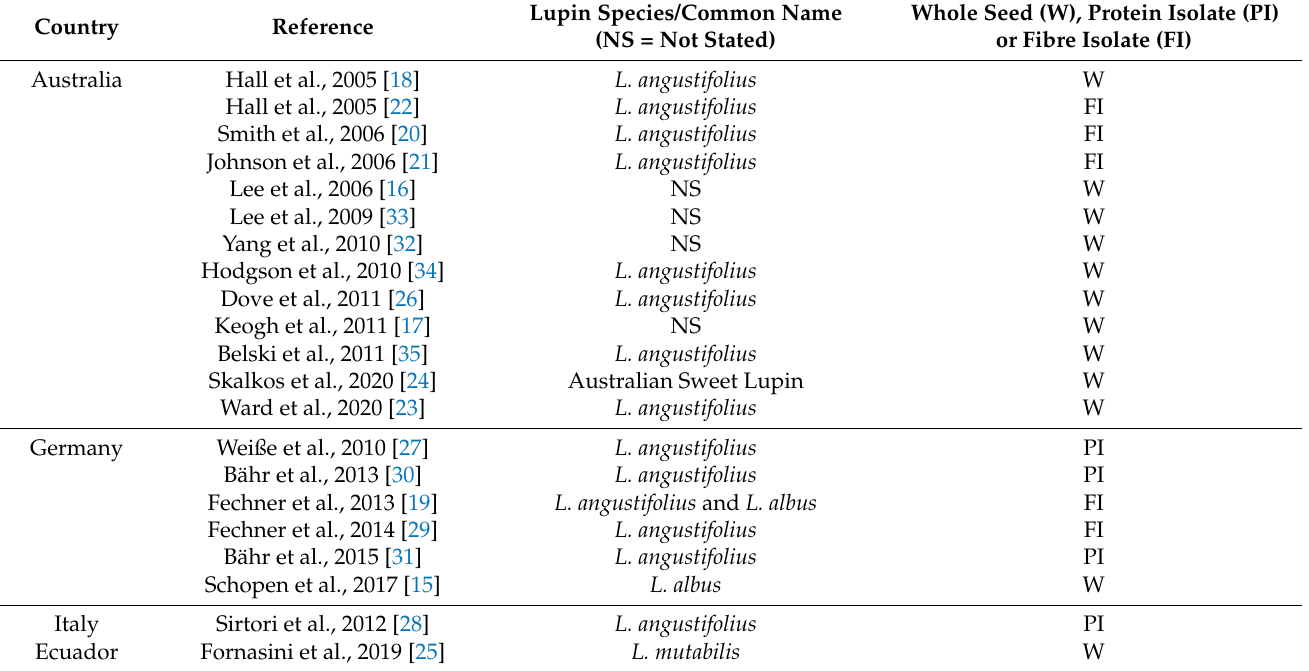
Table 1. Study location, lupin species and form of lupin consumed in eligible studies investigating the health benefits of lupin